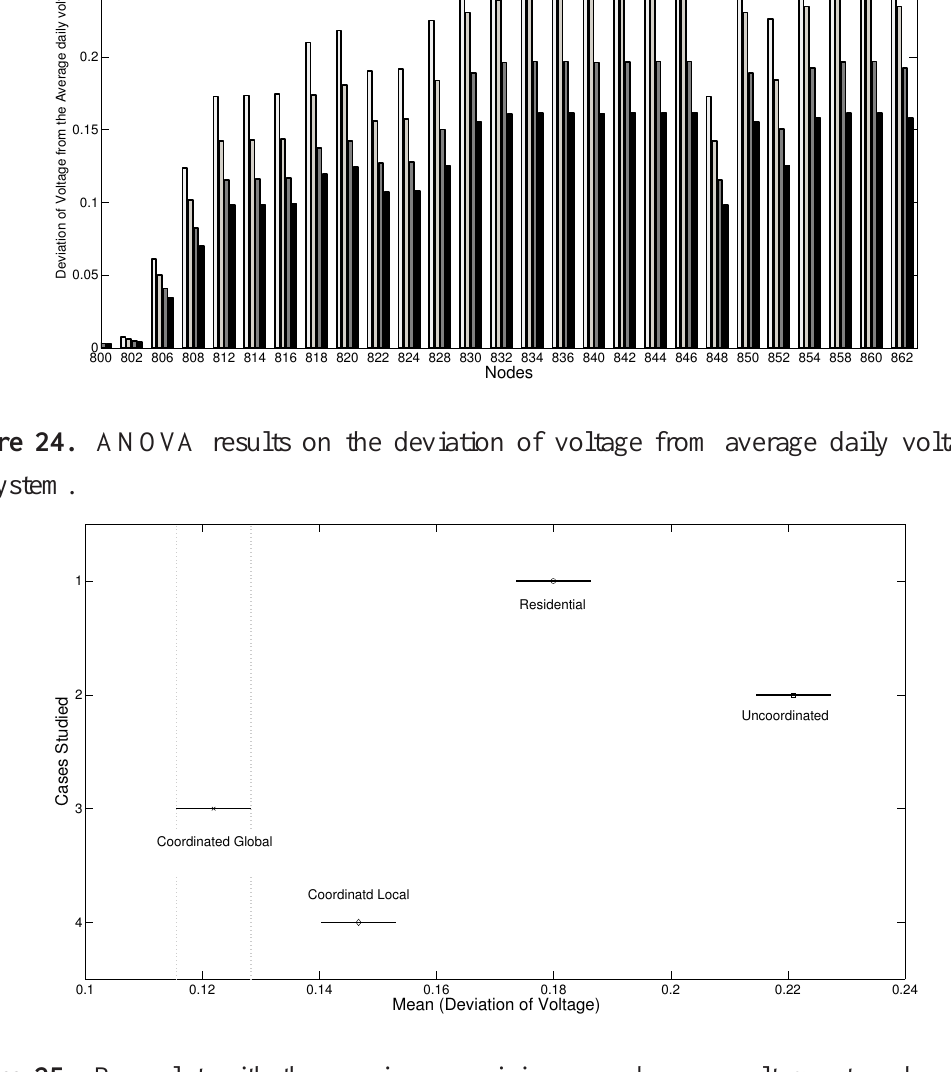
Figure 25. Box plot with the maximum, minimum and mean voltage at each node for 100 coordination